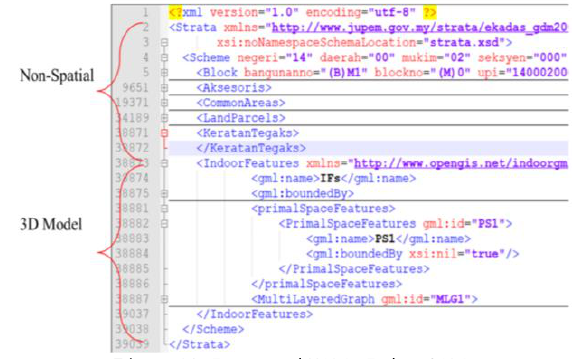
Figure 10. Integrated